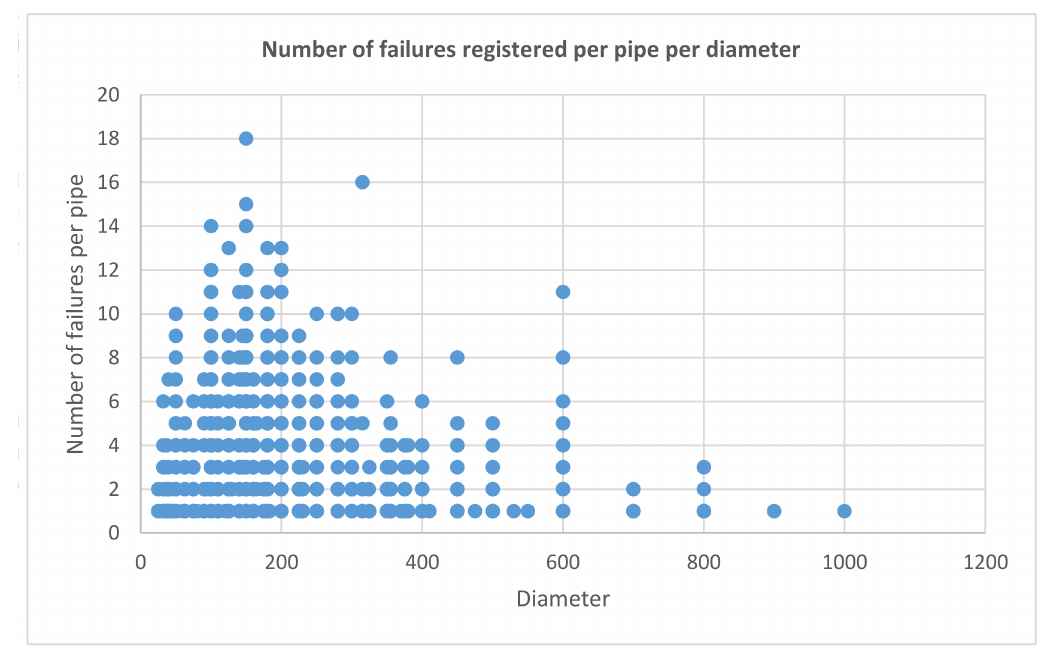
Figure 3. Number of failures correlated against diameter of pipes.